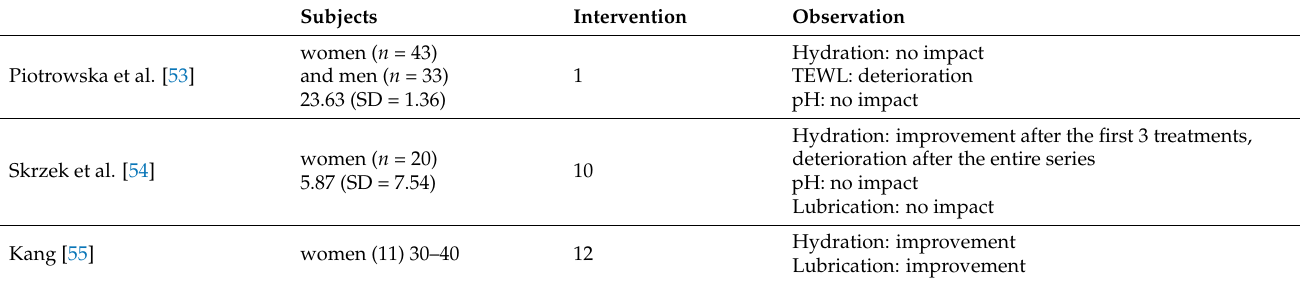
Table 1. Changes in selected skin features due to single or repeated whole-body cryotherapy